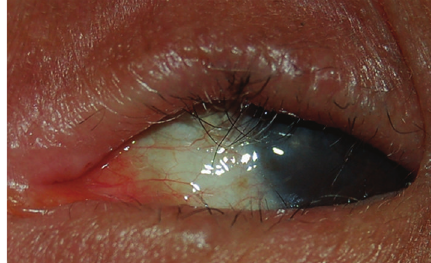
Figure 9: Trichiasis (TT stage). Figure courtesy of Hollman Miller, Vaup´es,